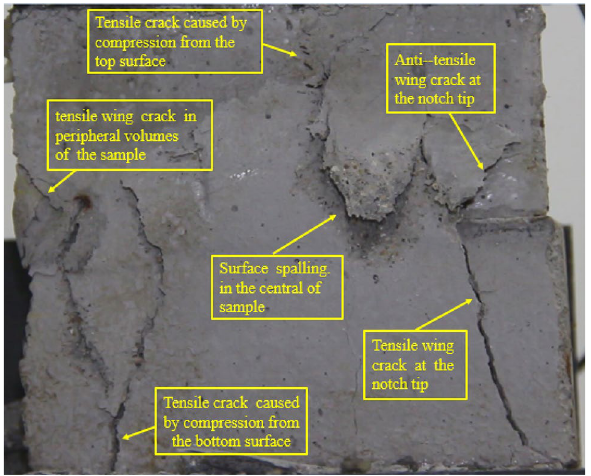
Figure 29. Photograph showing three types of tensile crack, two types of anti-tensile wing crack and surface spalling.